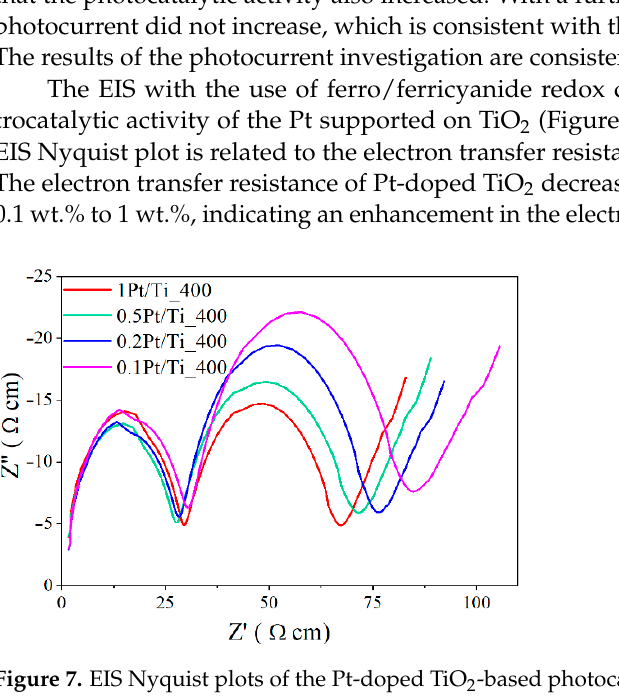
Figure 7. EIS Nyquist plots of the Pt-doped TiO 2 -based photocatalysts; electrolyte solution is 0.1 M KNO 3 containing 5 mM [Fe(CN) 6 ] 3–/4– . KNO 3 containing 5 mM [Fe(CN) 6 ] 3 − /4 −